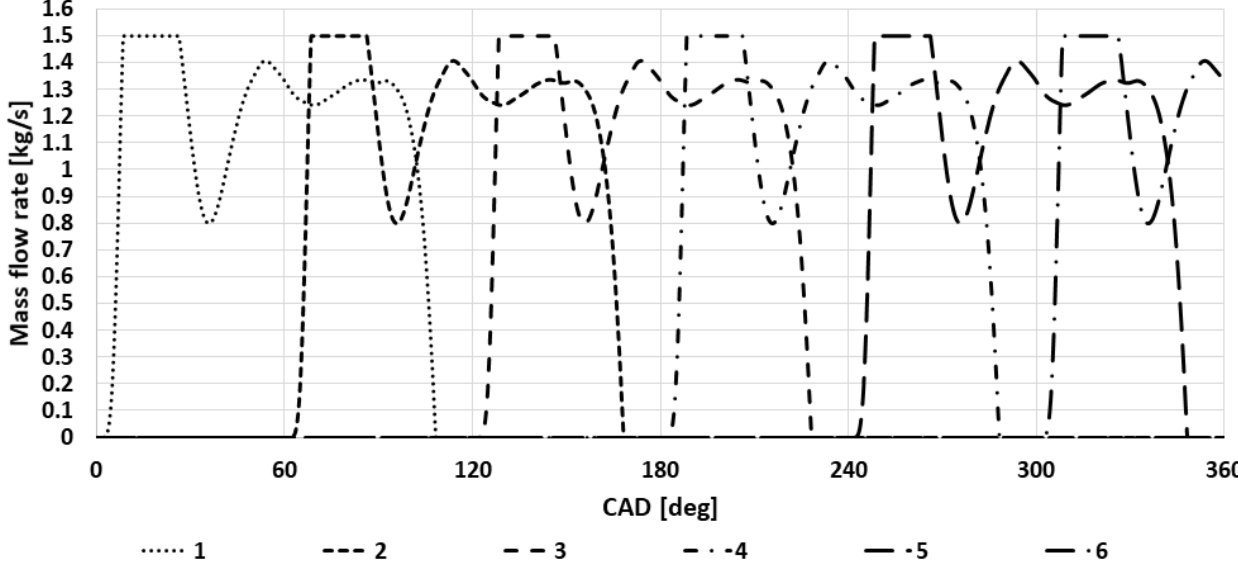
Figure 11. The mass-flow rate boundary conditions at the inlet to the six exhaust pipes during the single revolution of the crankshaft.